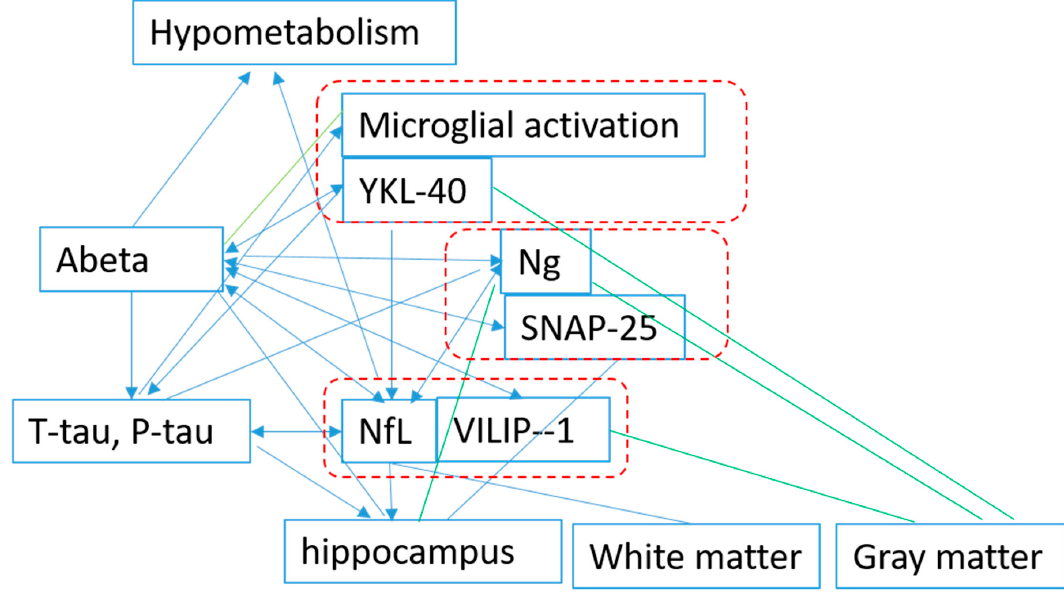
Figure 2. Association among the proteins based on studies published. A β : beta amyloid; Ng: neurogranin; SNAP-25: synaptosomal-associated protein 25; YKL-40: chitinase-3-like protein 1; NfL: neurofilament light chain; VILIP-1: visinin-like protein 1; Blue: association; Green: negative association.